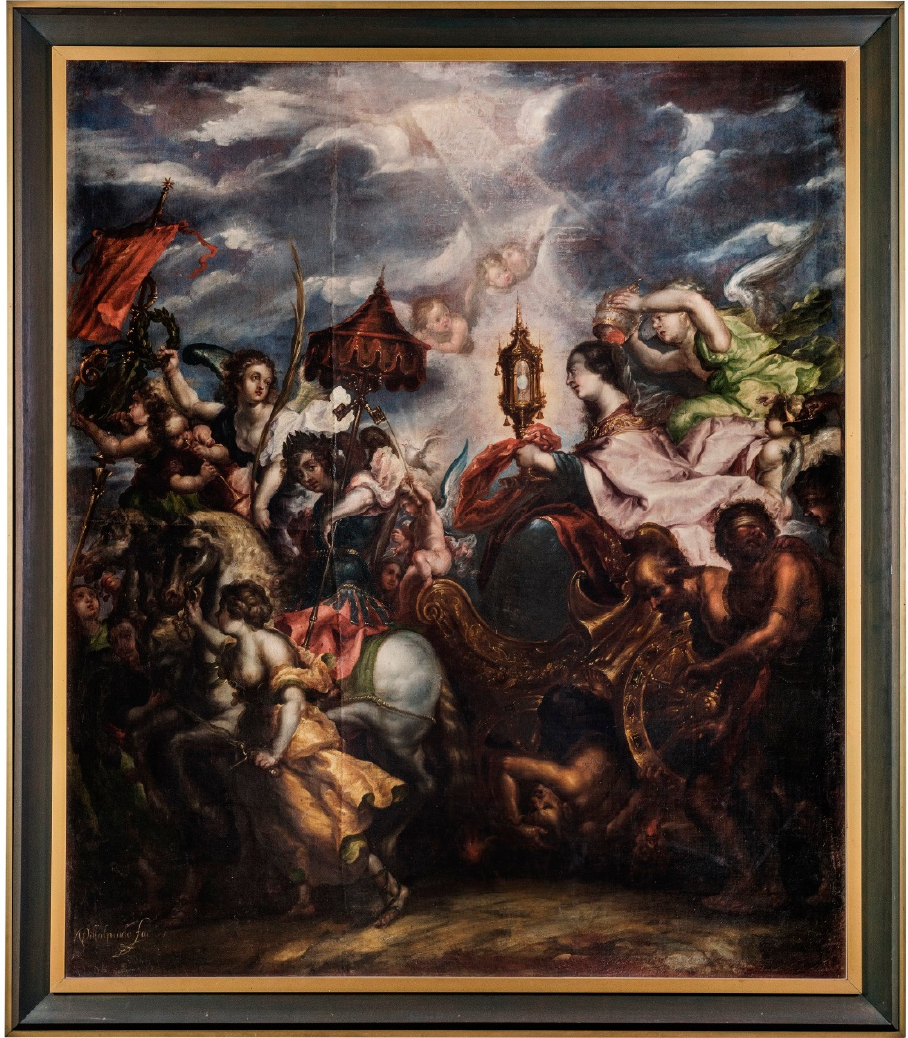
Figure 1. Cristóbal de Villalpando, El Triunfo de la Iglesia (end of the 17th–beginning of the 18th century), oil on canvas, 198 × 168.3 cm, Museo Regional de Guadalajara, Guadalajara. Photograph by: Gerardo Hernández Rosales. Reproduction authorized by the Instituto Nacional de Antropología e Historia.